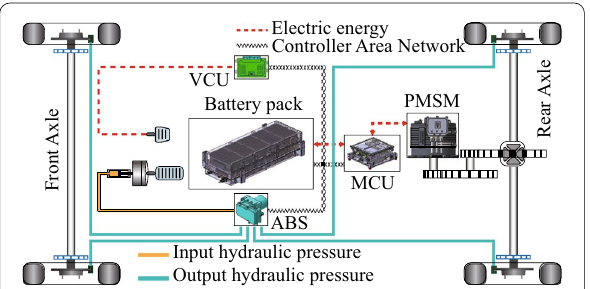
Figure 1 Architecture of battery electric